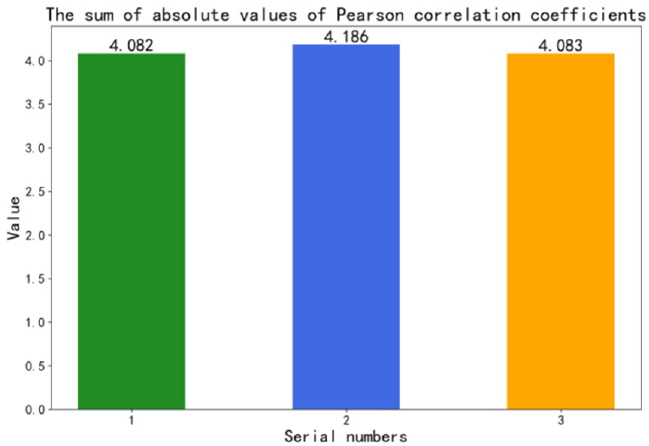
Figure 3. The sum of absolute values of Pearson’s correlation coefficients.